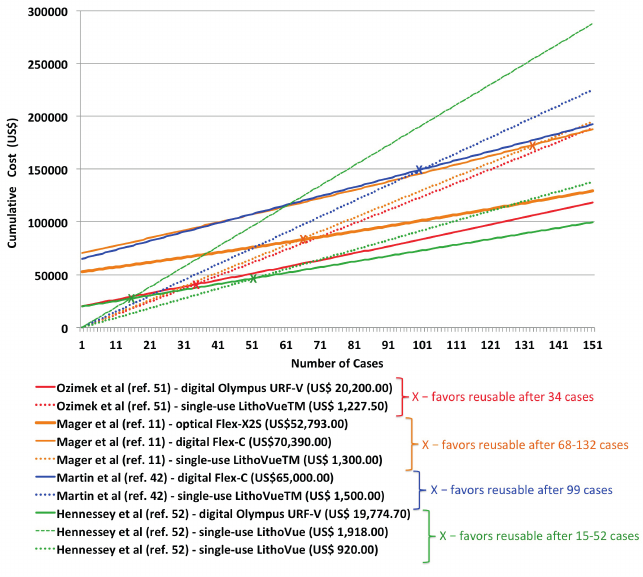
Figure 2 - Cumulative cost analysis between single-use and reusable flexible ureteroscopes among different published